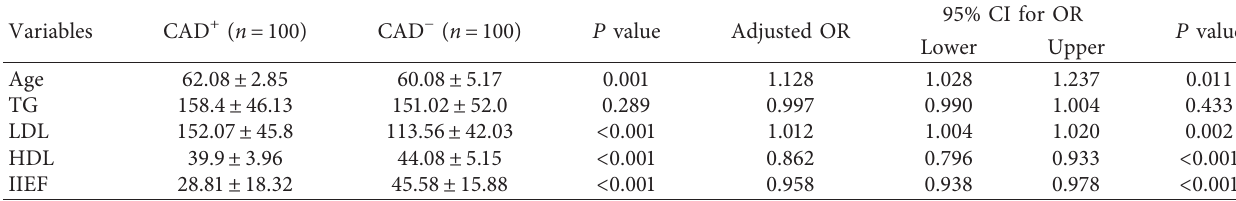
Table 1: Association between IIEF and CAD without and with adjusting other variables. Variables